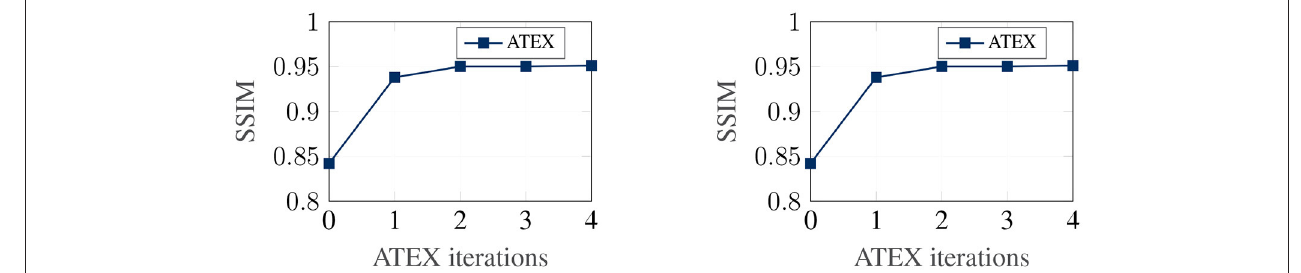
FIGURE 5 | Efficacy of adversarial training after apply ATEX. Left: FashionMNIST. Right: